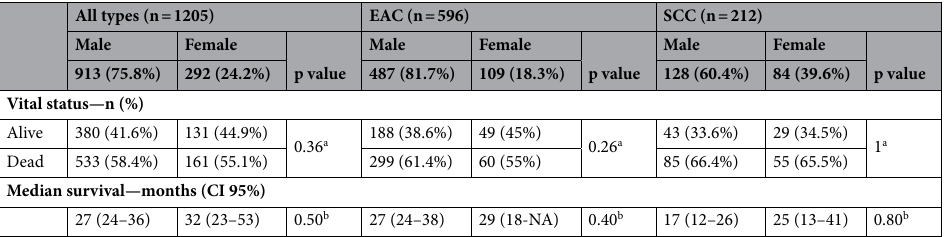
Table 5. Median survival by sex for all types of esophageal cancer combined, esophageal adenocarcinoma (EAC) and squamous cell carcinoma (SCC), UH Seidman Cancer Center Database (2005–2020). a Chi-square test. b Log-rank